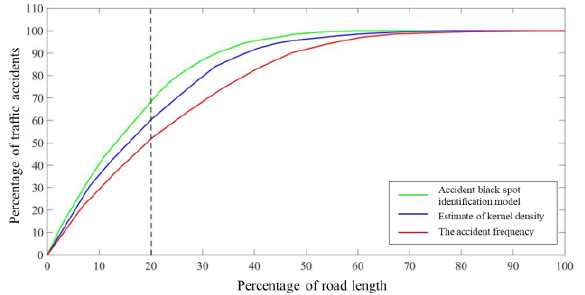
Figure 7. The relationship between the percentage of traffic accidents and the percentage of road length.